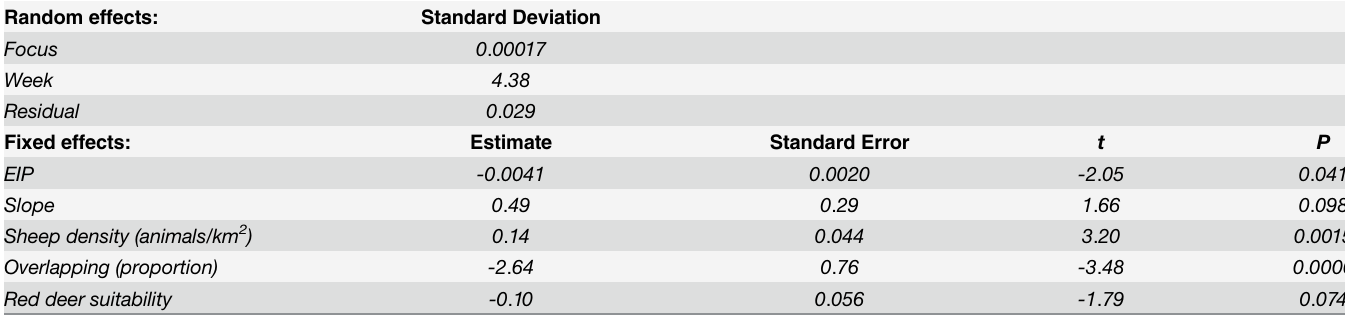
Table 1. Parameter estimates from the best-fitting mixed effects model used to evaluate the relative influence of different environmental variables on the estimated value of R t